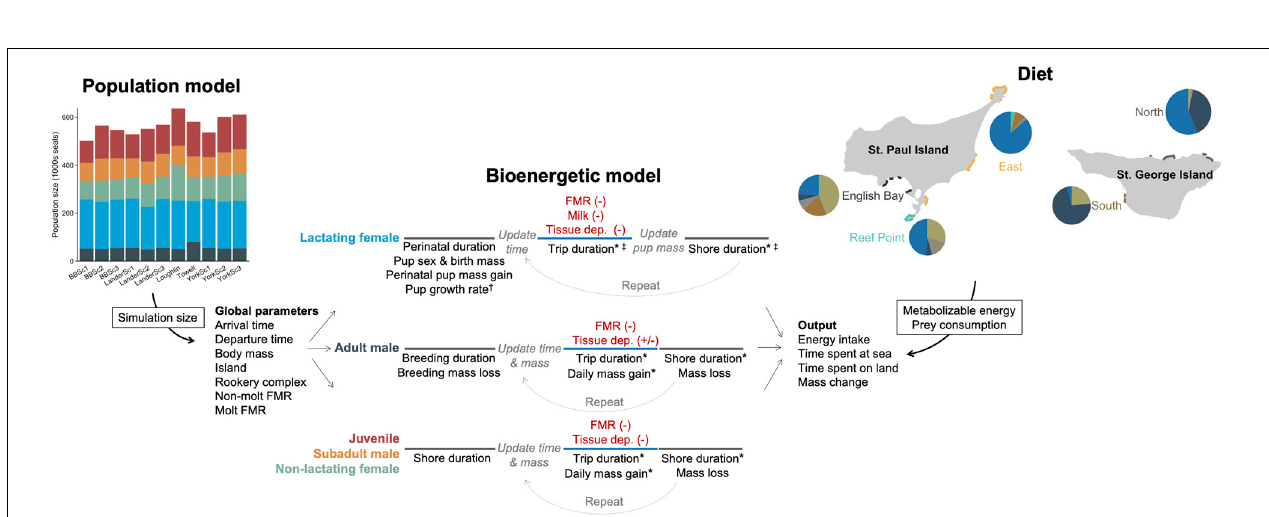
FIGURE 2 | Schematic illustrating the general structure and parameters of the bioenergetic model simulations and how additional data streams (population model, diet) were incorporated to estimate energy and prey consumption of northern fur seals. In the bioenergetic model, black text represents individual parameters, red text represents energetic costs, and line colors correspond to time at sea (blue) or onshore (gray). Parameter values were held constant for an individual, allowed to vary across foraging trips (*), model years ( † ), or month and island within a year ( ‡ ). Energetic costs were met from prey (-) except when tissue catabolism offset energetic needs (+). In the population model, each column represents a different model, with colors corresponding to each fur seal group (shown for a single year). In the diet figure, pie graphs represent the percentage contribution by energy of different prey species to the diet of northern fur seals (shown for a single year) and are separated by rookery complex to illustrate spatial variation in diet composition. The size of pie graphs relates to the proportion of pups born at each rookery complex within each island, which was the variable used to assign individual seals to each rookery complex.